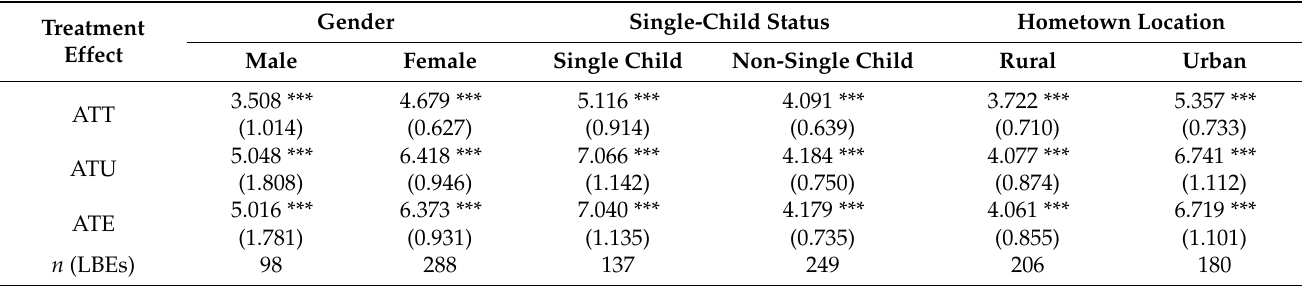
Table 7. Treatment effects of left-behind experience in